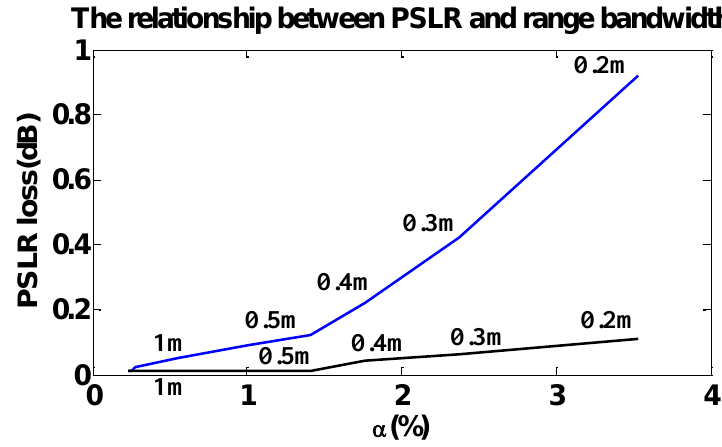
f , the black line shows the PSLR loss in the r f . The numbers beside the line show the two- r